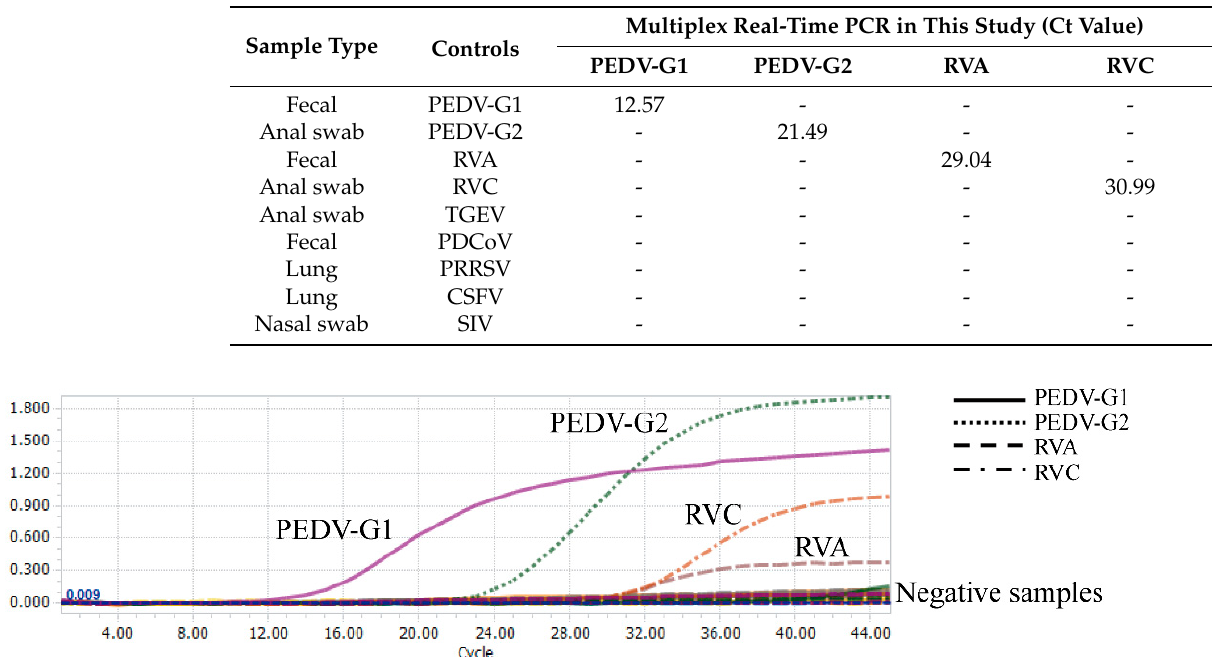
Table 3. Specificity of the multiplex real-time PCR assay.